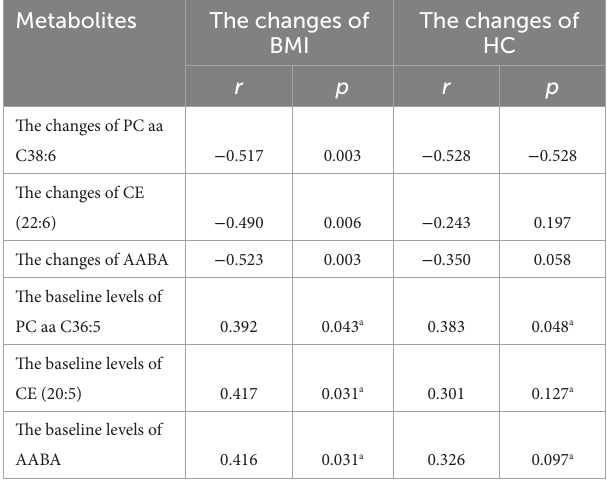
TABLE 3 The correlation between the changes of BMI, HC, and differential